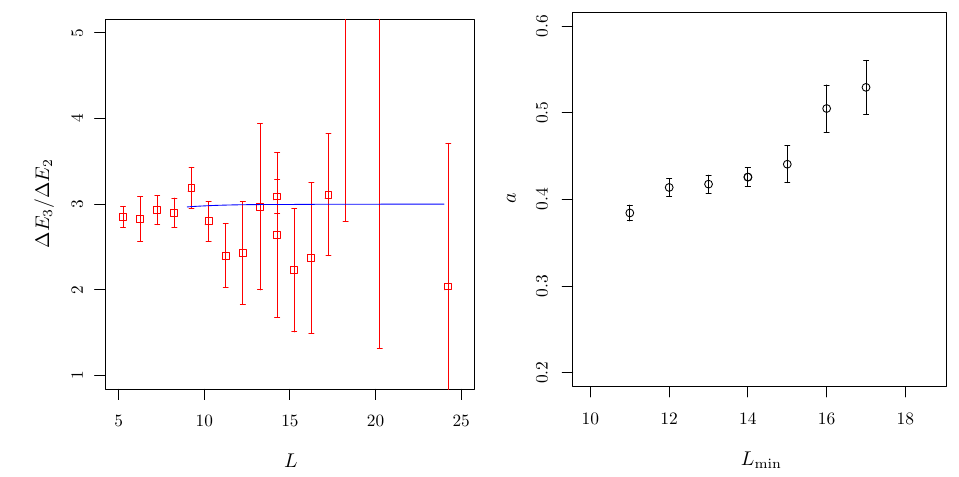
Fig. 7 Left: ratio (cid:7) E 3 /(cid:7) E 2 as a function of L . The solid line represents the ratio computed from the best fit parameters from Table 1, using Eqs. (20) and (21). Right: scattering length a as a function of L min determined fits of Eq. (21) up to order L − 5 to our data for (cid:7) E 3 , i.e. with a the only fit parameter